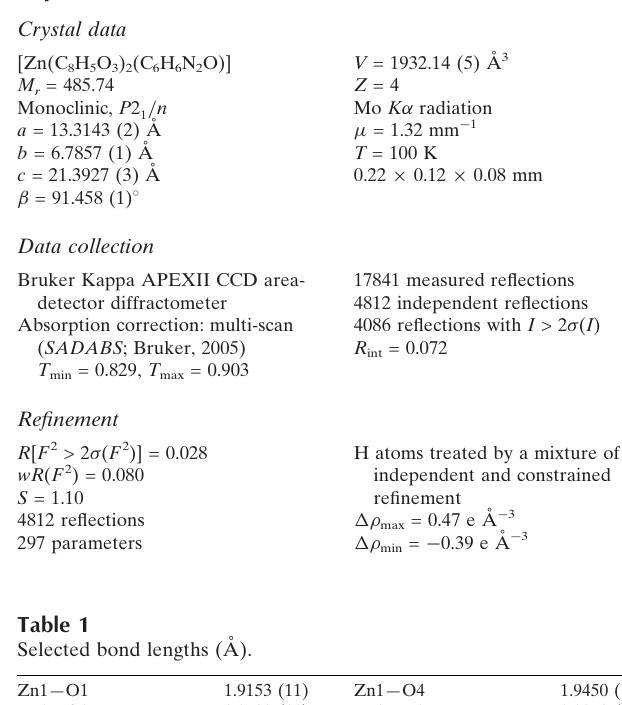
Bruker Kappa APEXII CCD area- detector diffractometer